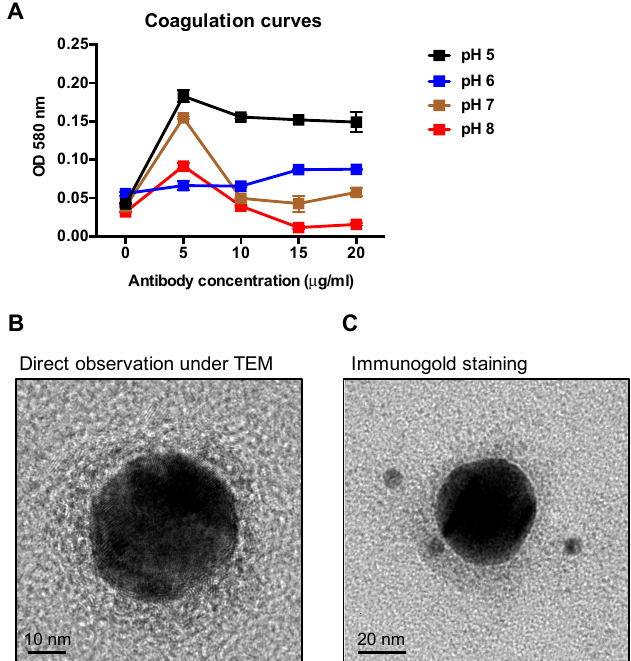
Figure 2. Coagulation curve analysis and immunogold staining of colloidal gold-labelled mAb. ( A ) The optimal pH value of gold particles and the concentration of mAb LK2-11a for stabilizing colloidal gold particles were determined by the coagulation curve analysis. The OD absorbance of each sample was determined at 580 nm. After the tracer (the mAb-gold complexes) was prepared, it was examined using transmission electron microscopy; ( B ) and stained by the goat anti-mouse IgG 6-nm gold conjugate ( C ).